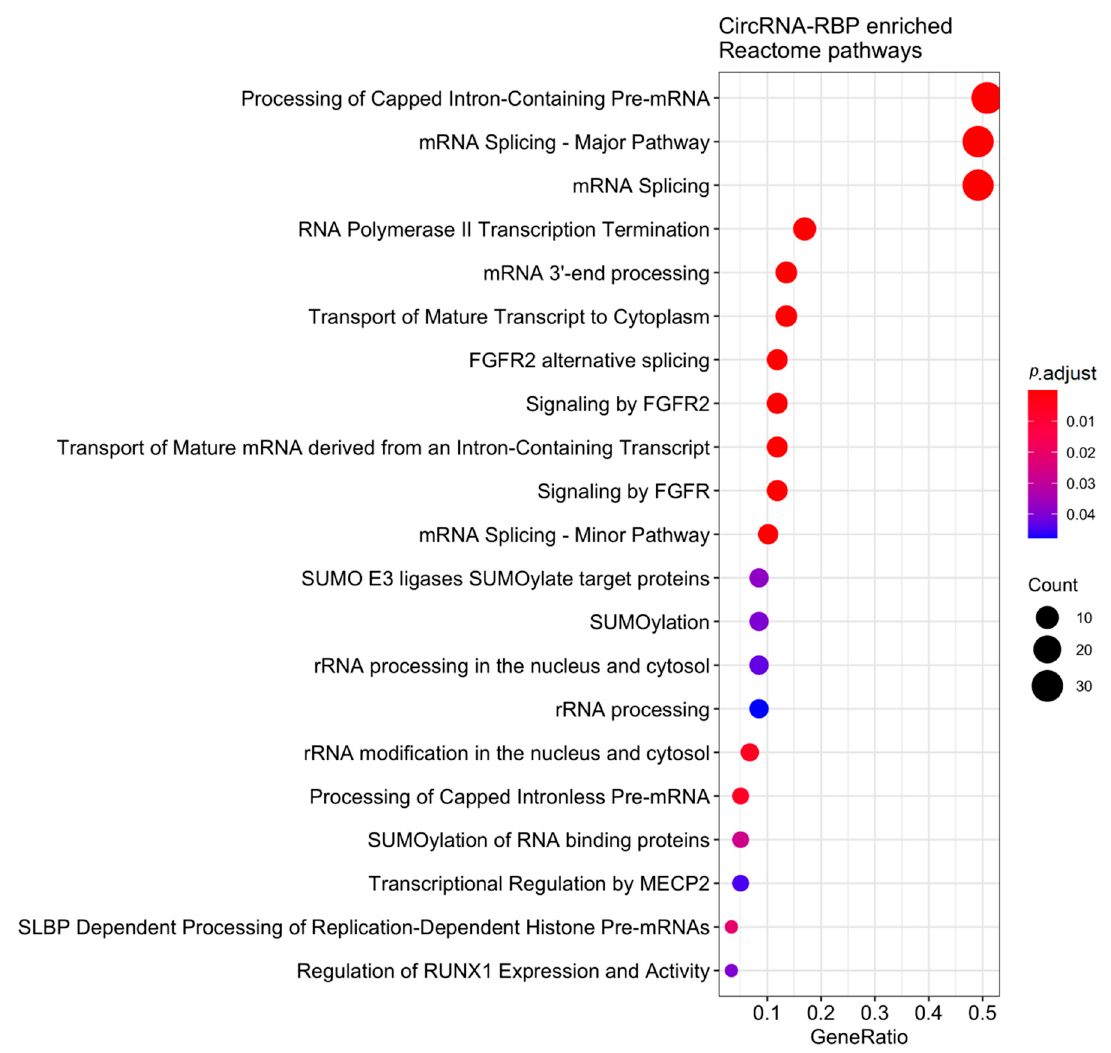
Figure 4. Reactome pathways for which the sponge circRNAs’ target RBPs are enriched.